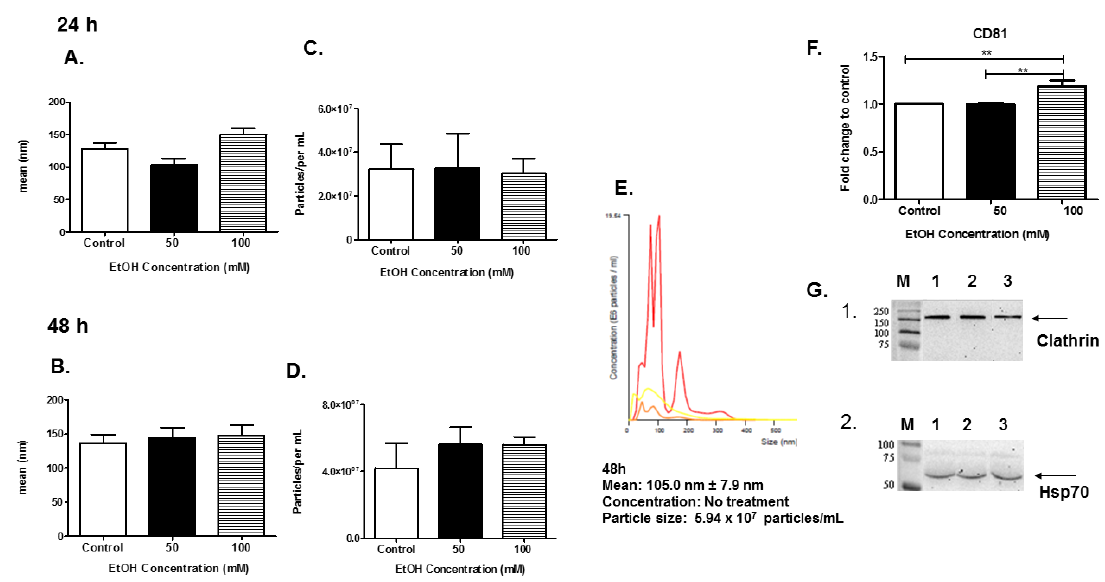
Figure 2. Validation of HeLa-derived EVs. Nanosight tracking analysis (NTA)-generated ( A , B ) size and ( C , D ) concentration of vesicles obtained from five independent experiments after EtOH administration. ( E ) Histogram plot of control EVs collected at 48 h. The di ff erent colored lines represent di ff erent pools of EVs. ( F ) CD81 was observed in HeLa-derived EVs via ELISA. ( G ) Western blots of HeLa-derived EVs, 60 µ g / lane, were probed with (1) clathrin or (2) Hsp70 antibodies. Arrows indicate proteins of interest. Significance is defined as ** p ≤ 0.01.